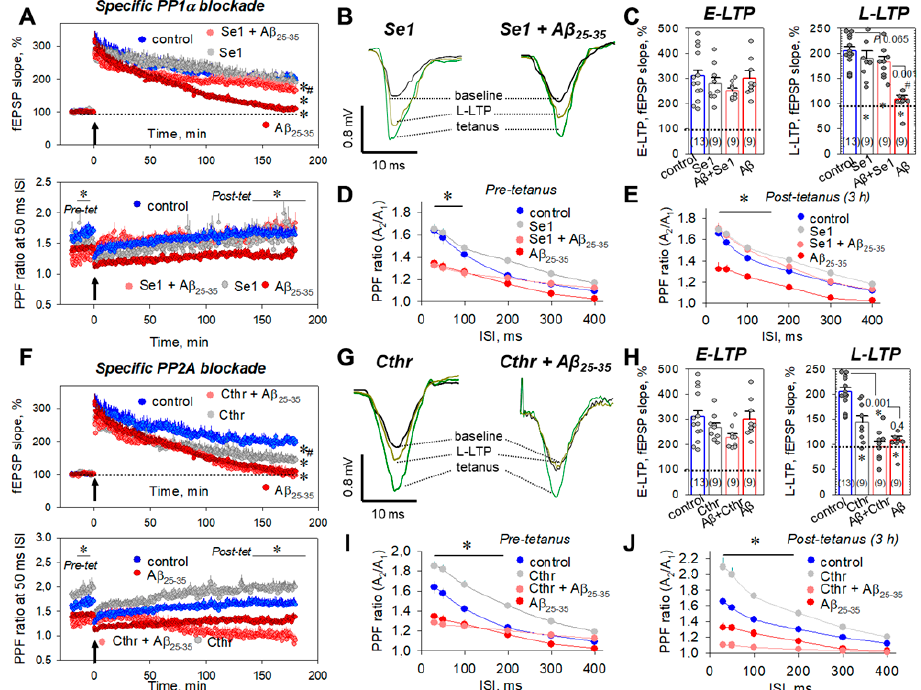
Figure 4. Selective PP1 α or PP2A blockade during the A β 25-35 -dependent impairment of hippocampal synaptic plasticity. ( A ) Averaged curves for control slices (blue circles, n = 13), sephin1 (Se1)-treated slices (10 μ M, gray circles, n = 9), A β 25-35 -treated slices (dark red circles, n = 9), and Se1 + A β 25-35 -treated slices (red circles, n = 9). Arrow at 0 min indicates start of tetanic stimulation; dotted line 100% represents normalized fEPSPs corresponding to the pre-tetanic level. Bottom panel represents paired-pulse facilitation (PPF) curves at the 50 ms ISI. ( B ) Typical fEPSP responses of studied groups for pre-tetanic levels (baseline), at the start of post-tetanic recordings (tetanus) and 180 min after LTP induction (L-LTP). ( C ) Summarized statistics for ( A ) curves during early phase (E-LTP, 0–3 min) and late phase (L-LTP, 178–180 min) of long-term potentiation. * denotes p < 0.05 for comparing the group with control; # indicates p < 0.05 for comparison groups between themselves. The number of independent experiments corresponding to different animals is indicated in parentheses. PPF ratios for different interstimulus intervals (30–400 ms) before tetanic stimulation (( D ), pre-tetanus) and for L-LTP, 3 h after tetanus (E, post-tetanus). ( F ) Final curves for control slices (blue circles, n = 13), cantharidin (Cthr)-treated slices (10 μ M, gray circles, n = 9), A β 25-35 -treated slices (dark red circles, n = 9), and Cthr + A β 25-35 -treated slices (red circles, n = 9). Arrow at 0 min indicates start of tetanic stimulation; dotted line 100% represents normalized fEPSPs corresponding to the pre-tetanic level. Bottom panel represents paired-pulse facilitation (PPF) curves at the 50 ms ISI. ( G ) Typical fEPSP responses of studied groups for pre-tetanic levels (baseline), at the start of post-tetanic recordings (tetanus) and 180 min after LTP induction (L-LTP). ( H ) Summarized statistics for ( F ) curves during early phase (E-LTP, 0–3 min) and late phase (L-LTP, 178–180 min) of long-term potentiation. * denotes p < 0.05 for comparing of the group with control; # indicates p < 0.05 for comparison of groups between themselves. The number of independent experiments corresponding to different animals is indicated in parentheses. PPF ratios for different interstimulus intervals (30–400 ms) before tetanic stimulation (( I ), pre-tetanus) and for L-LTP, 3 h after tetanus (( J ), post-tetanus).